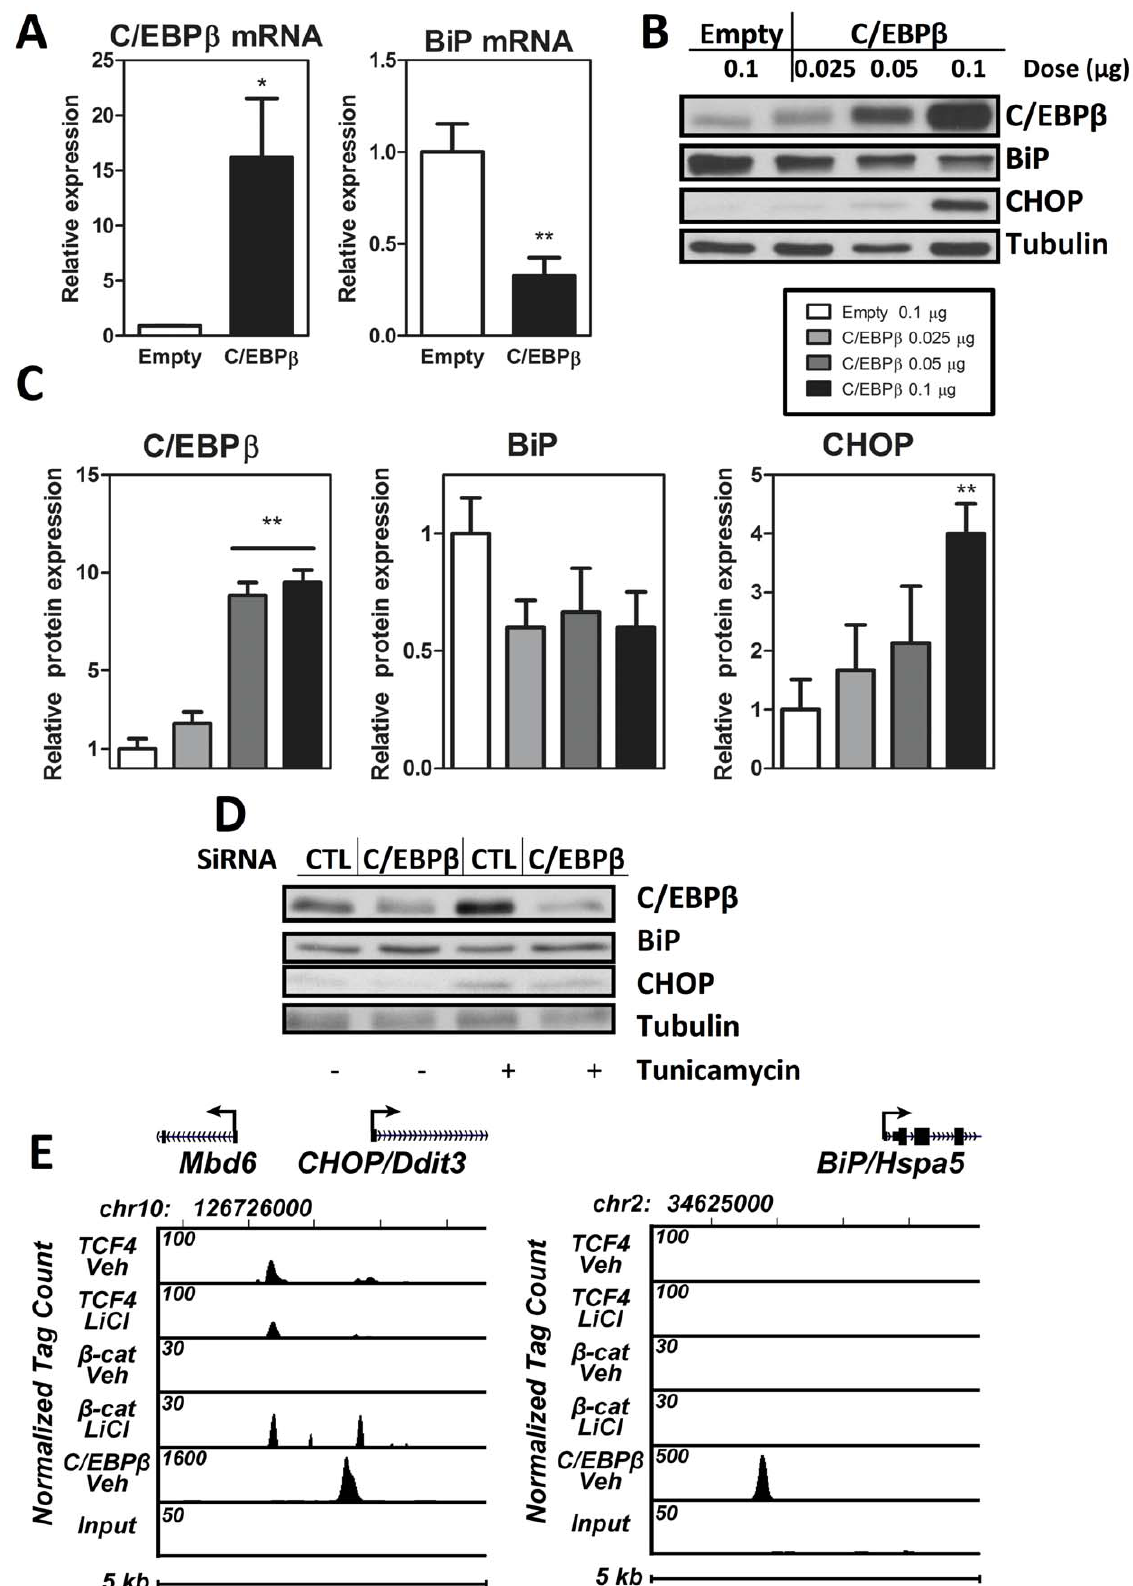
Figure 3. C/EBP b is involved in ER stress in MSC. A, C3H10T1/2 cells were transfected with 1 m g of C/EBP b versus empty vector. 48 hours after transfection, RNA analysis was performed via real time PCR (n=5). B, C3H10T1/2 cells transiently transfected with C/EBP b versus empty vector at